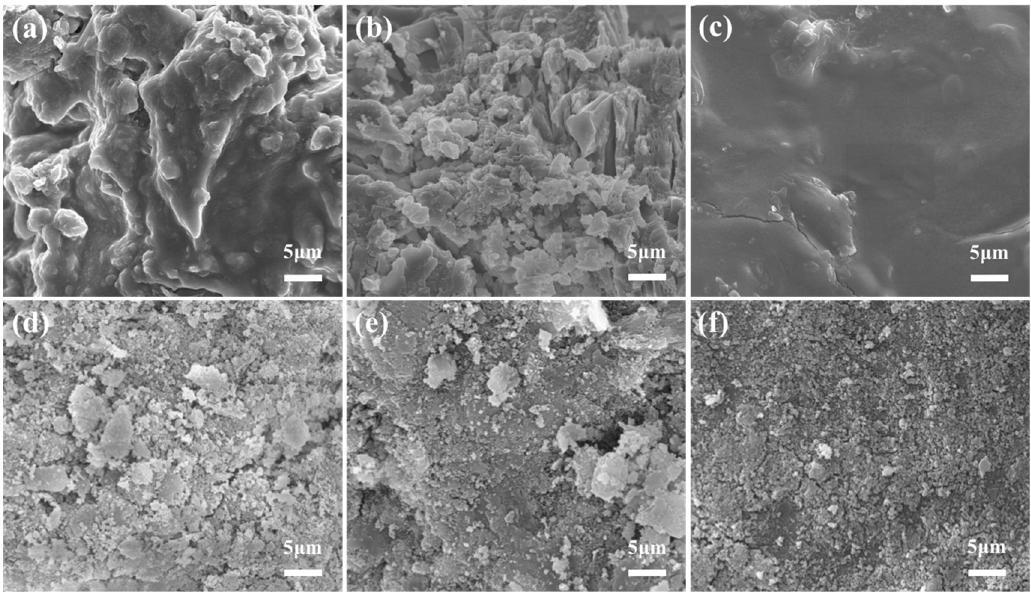
Figure 6. The SEM images of GTGs-0 ( a – c ) and GTGs-2 ( d – f ) after 3, 7, and 28 days of curing, respectively.